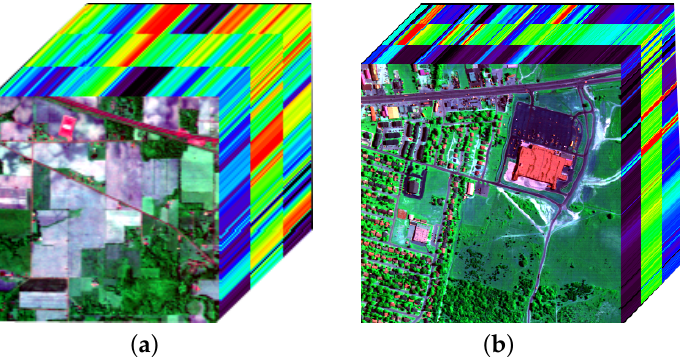
Figure 13. ( a ) AVIRIS Indian Pines dataset, ( b ) HYDICE Urban dataset.